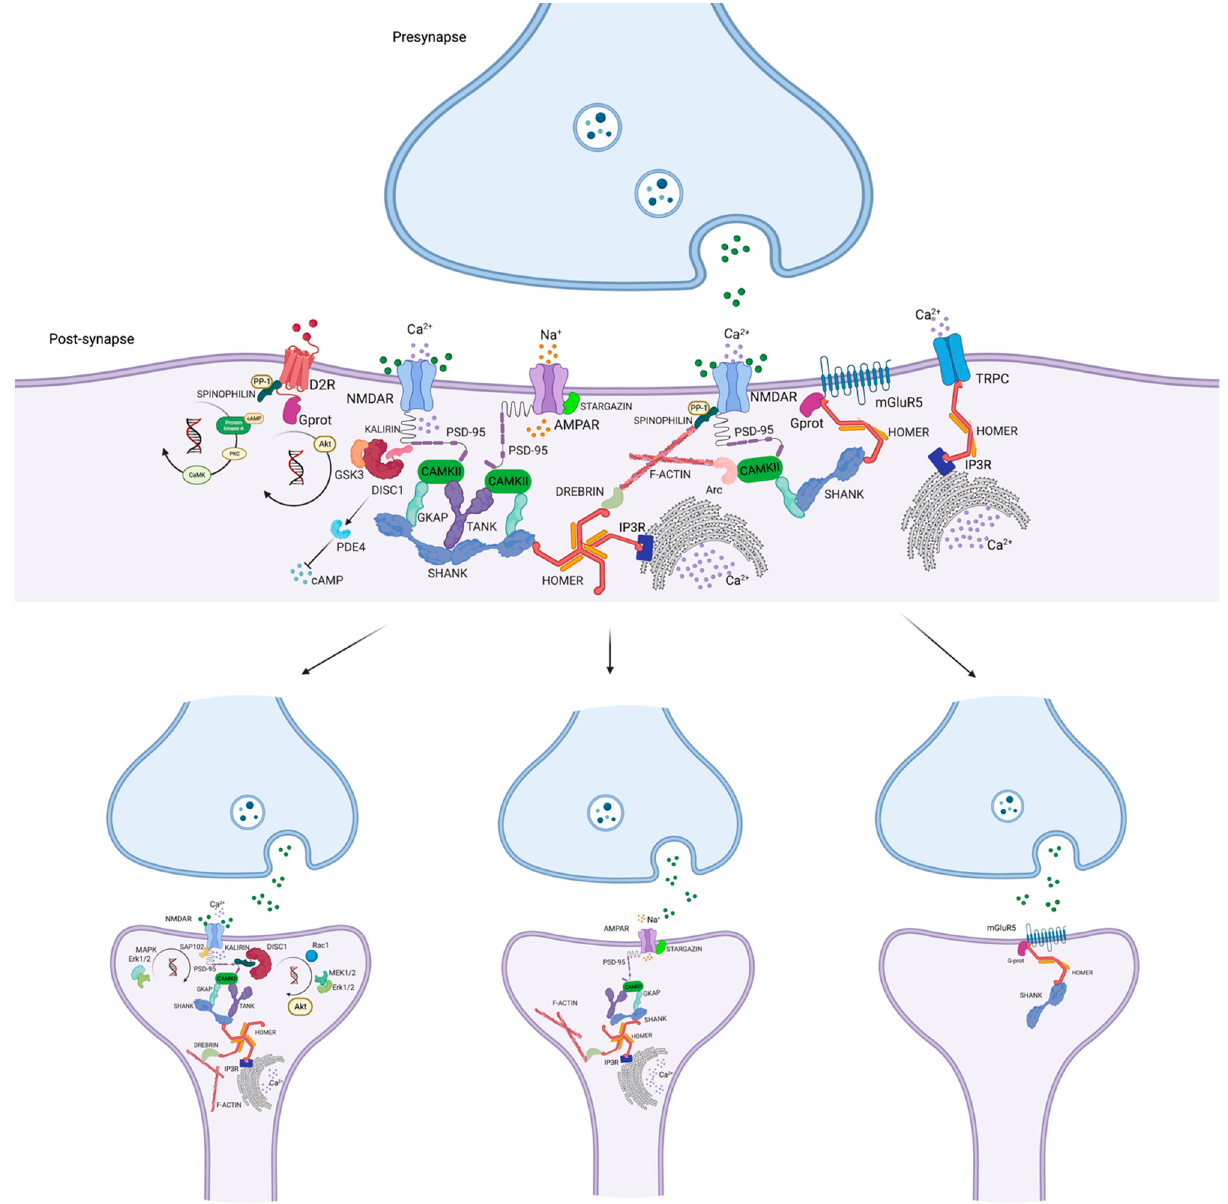
Figure 2. Focus on signaling at the PSD: NMDAR, AMPAR, mGluR5. Representation of transduction pathways of glutamatergic and dopaminergic receptors at the PSD. AMPAR = α -amino-3-hydroxy-5-methyl-4-isoxazolepropionic acid receptor; CAMKII = calcium–calmodulin (CaM)-dependent protein kinase II; F-ACTIN = filamentous actin; GKAP = guanylate kinase-associated protein; mGluR5 = metabotropic glutamate receptor 5; NMDAR = N-methyl-D-aspartic acid receptor; PSD-95 = postsynaptic density protein 95; SHANK = SH3 and multiple ankyrin repeat domains; TANK = TRAF family member associated NFKB activator; PP-1 = protein phosphatase 1; D2R = dopamine receptor D2; Gprot = G protein; cAMP = cyclic adenosine monophosphate; AKT = protein kinase B; PKC = protein kinase C; GSK3 = glycogen synthase kinase 3; Ca 2+ = calcium ion; DISC1 = disrupted-in-schizophrenia 1; PDE4 = phosphodiesterase 4A; Na + = sodium ion; IP3R = inositol 1,4,5-trisphosphate receptor, type 3; TRPC = transient receptor potential cation channel; SAP102 = synapse-associated protein 102; MAPK = mitogen activated protein kinases; Erk = extracellular signal-regulated kinase; Rac1 = Rac family small GTPase 1; MEK = mitogen-activated protein kinase. Created with BioRender.com; last access on 30 November 2022.